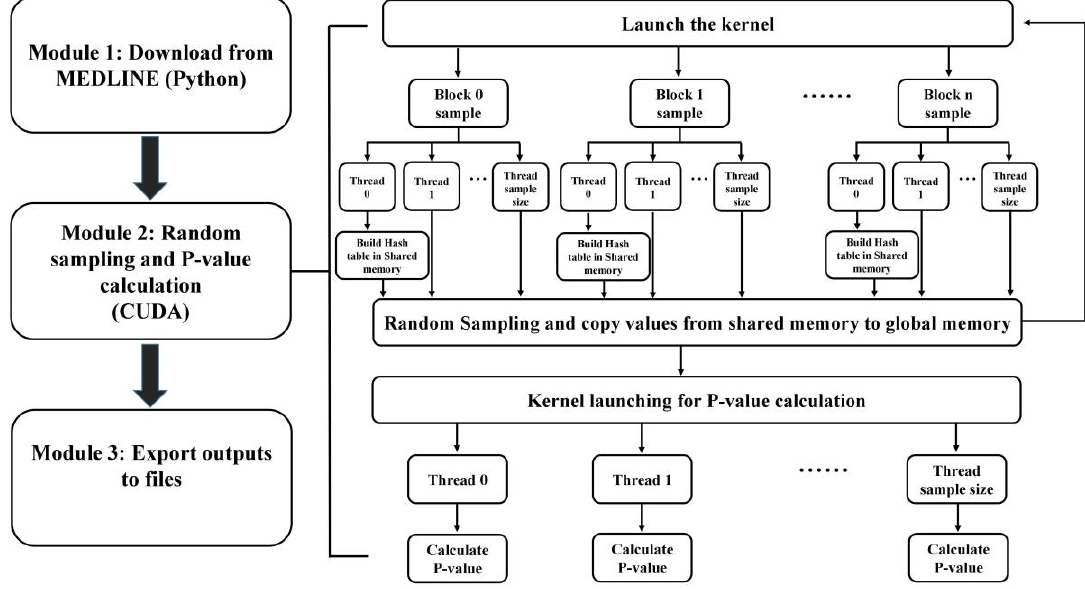
Figure 3. The flowchart of the process in CuDDI.